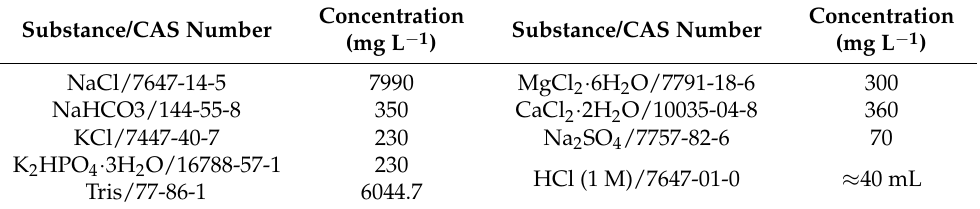
Table 1. Chemical composition of